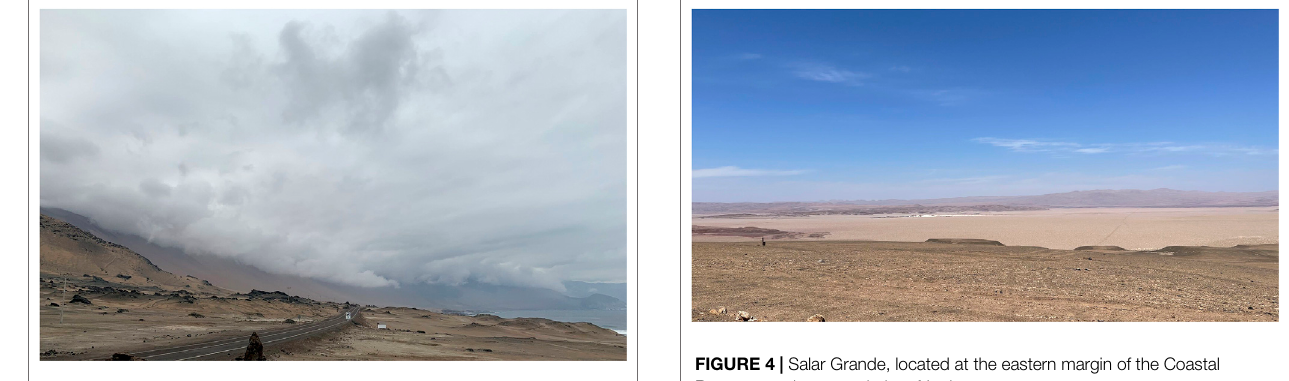
FIGURE 3 | Low-altitude clouds that originate in the Paci fi c Ocean (locally known as camanchaca) as they encounter the Coastal Range of the Atacama.